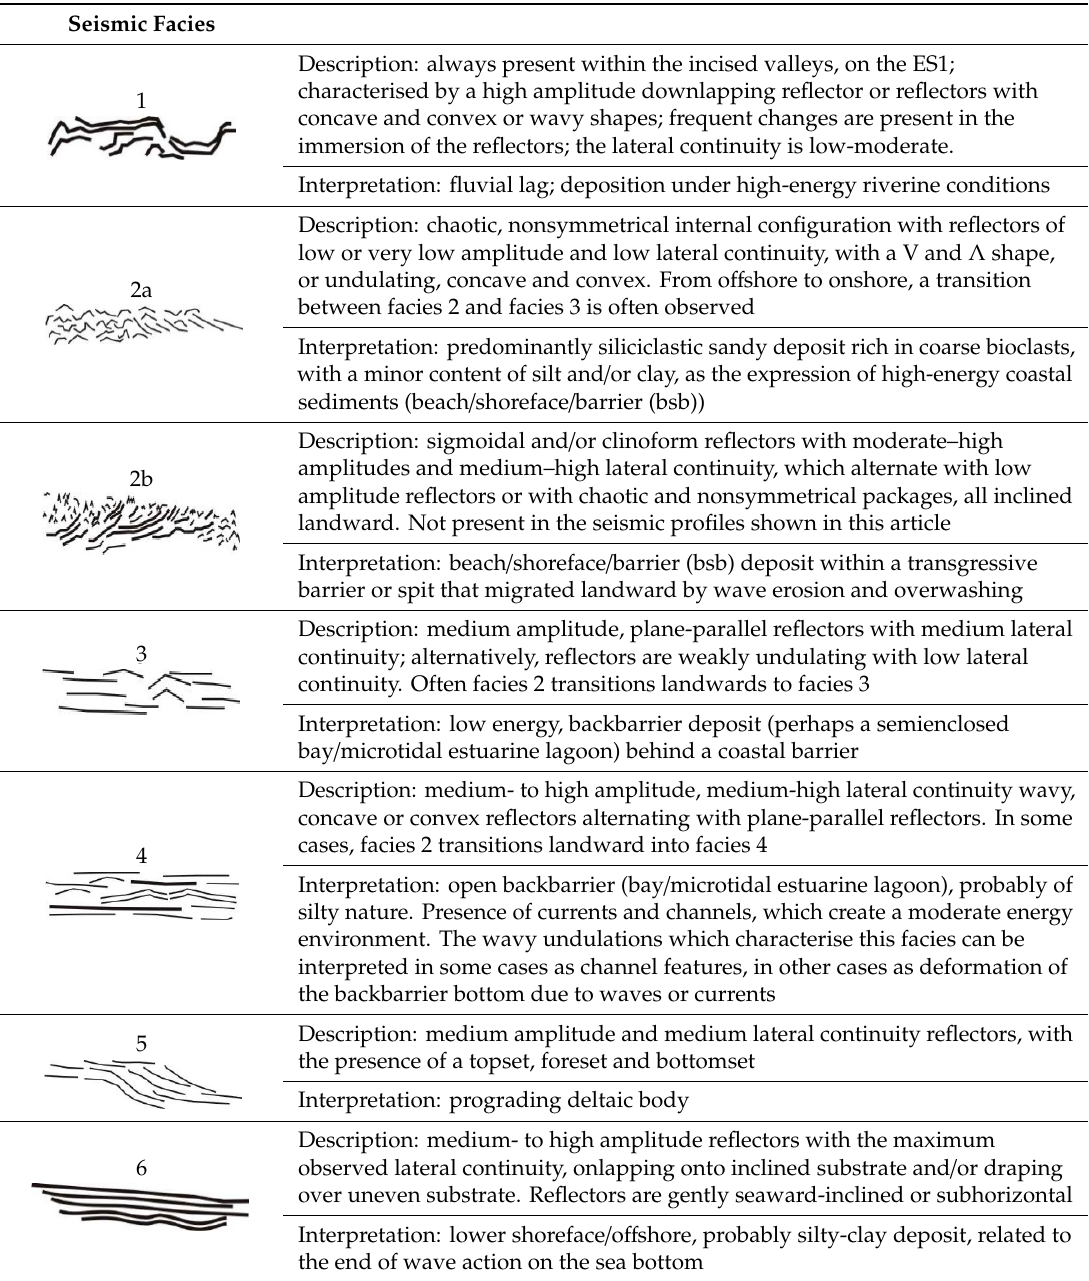
Table 1. Simplified sketch and short description of seismic facies recognised within the unconformity-bounded seismic units (UBSUs) belonging to the transgressive systems tract (TST) in the Manfredonia Gulf area.